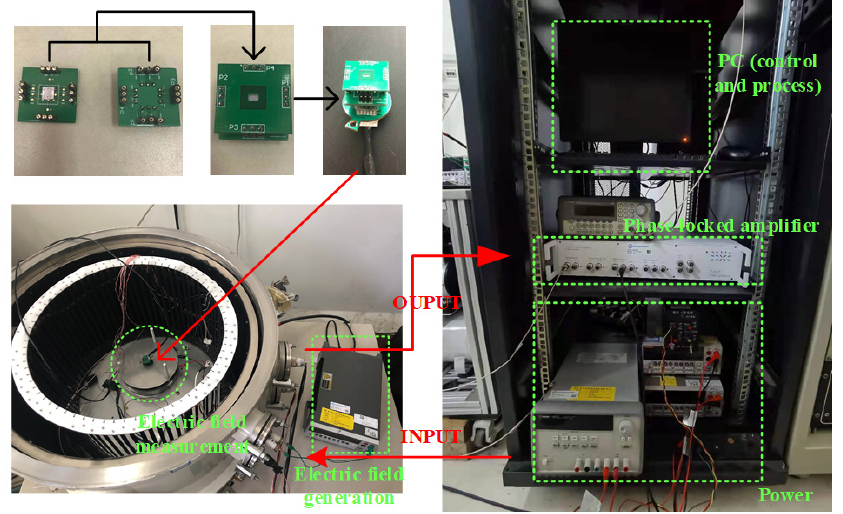
Figure 9. Photographs of the test system.